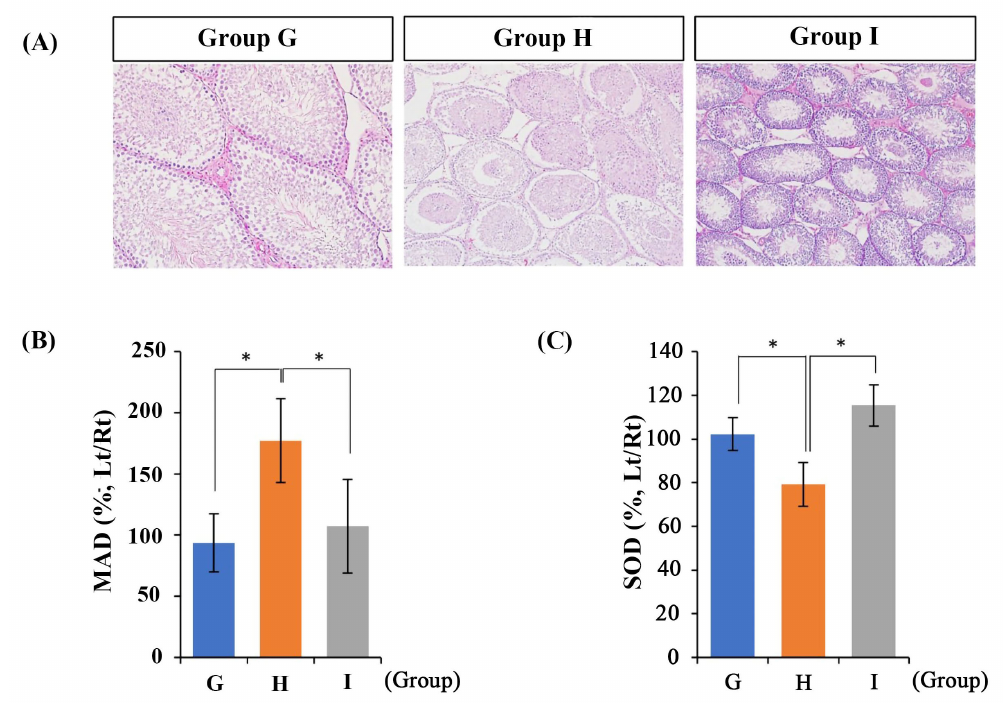
Fig. 4. Representative histopathologic images of the left testes (A) and the oxidative stress-related molecular markers, such as MDA (B) and SOD (C) in groups G–I (n = 8 in each group). The magnification of the image is 100 × . Group G: sham operation; Group H: torsion/detorsion (control group); Group I: torsion/detorsion with single administration of 0.3 mg/kg tadalafil one hour before detorsion (* p <